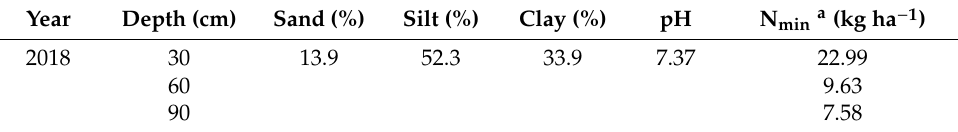
Table 2. Soil characteristics of the experimental site at Ihinger Hof in